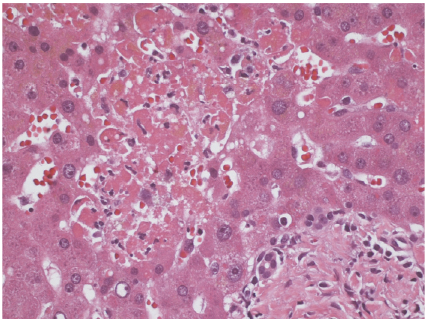
Figure 6: Hepatocytes with frank necrosis.